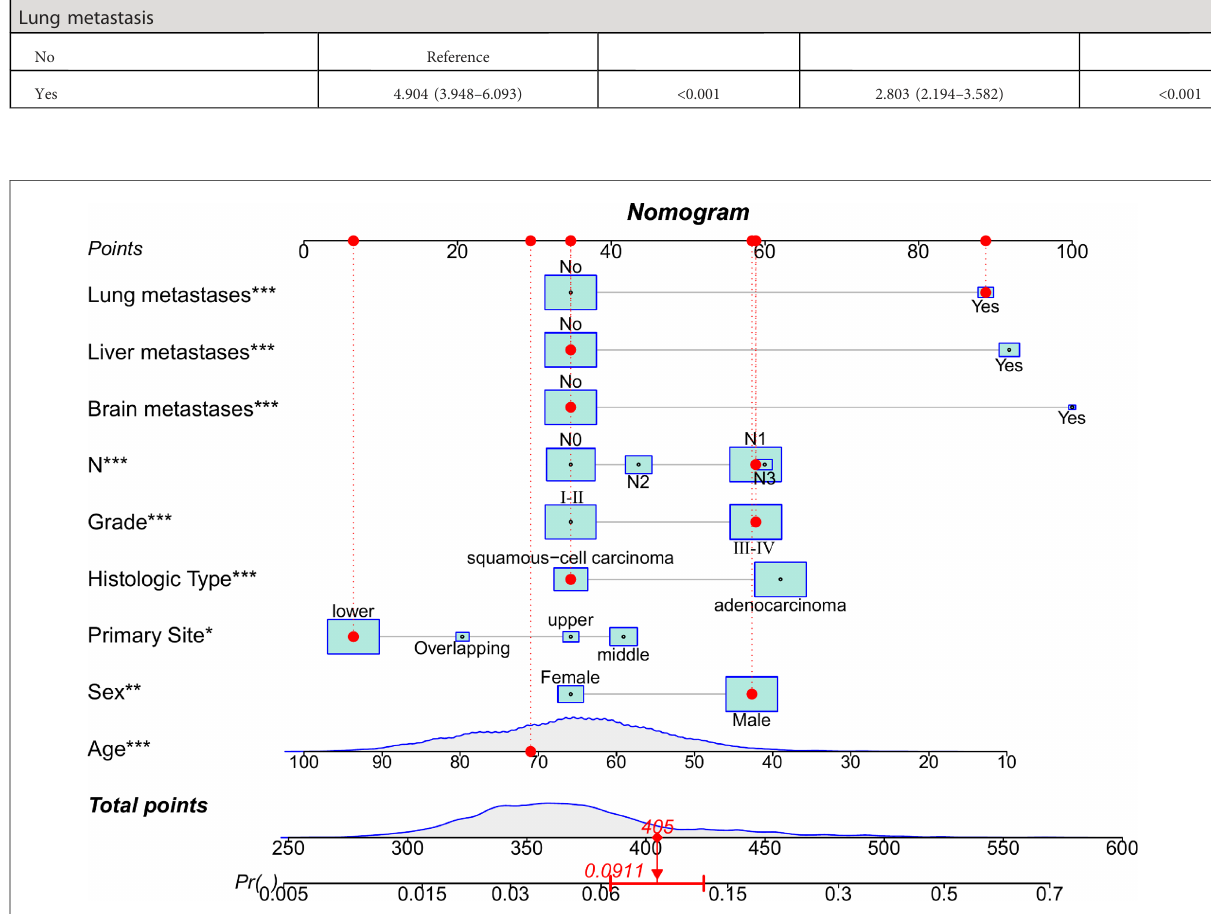
FIGURE 2 Nomogram to predict the risk of bone metastasis. A random patient was used as a demonstration. The red dot corresponds to the points of each predictor. The sum of the values for each predictor is given as total points, which corresponds to the probability of BM shown at the bottom of the chart. And the red arrow below represents the probability of bone